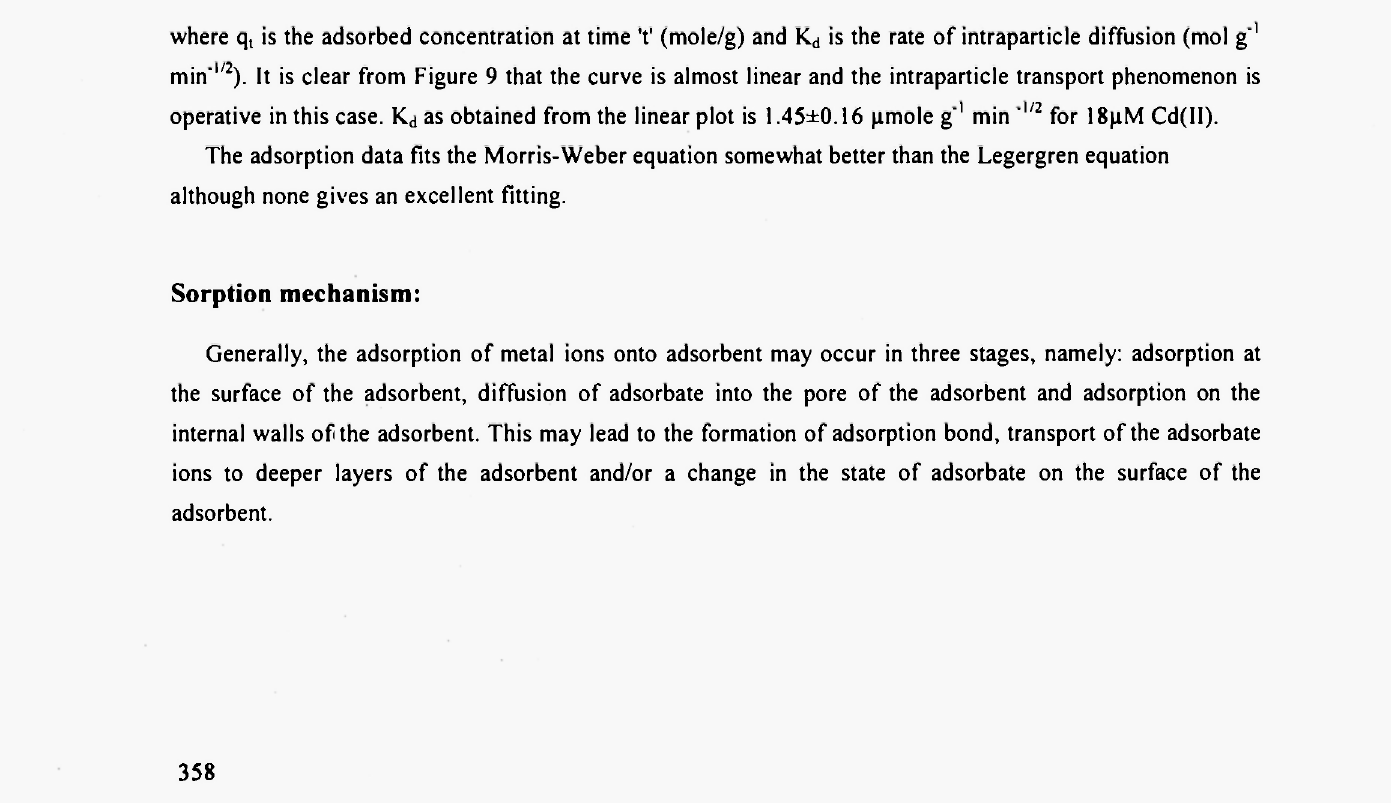
Fig. 8: Lagergren plot for the adsorption of Cd(II) ions onto